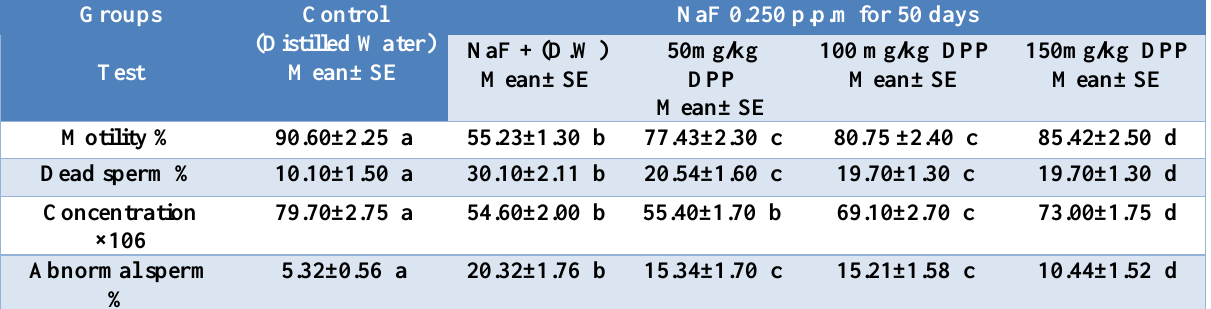
Different letters refer to significant (p<0.05) differences compared between